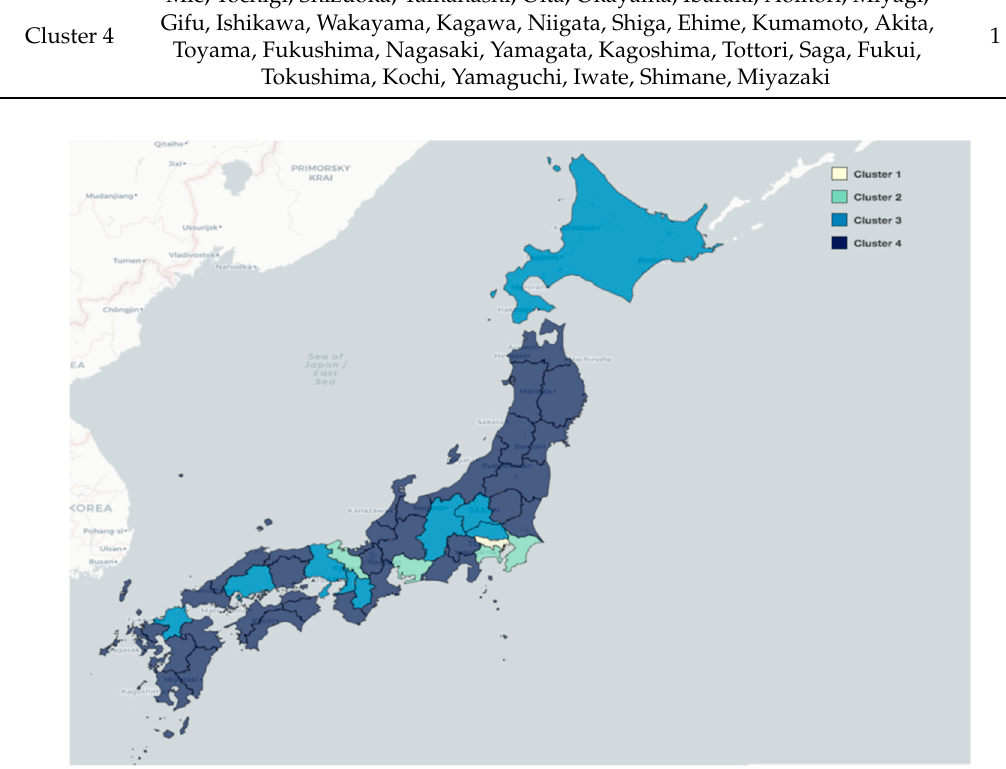
Figure 3. Distribution of prefecture clusters.